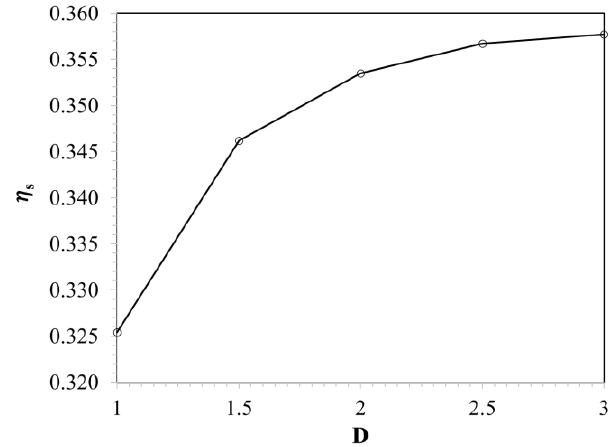
Figure 15. 𝜂 𝑠 with expansion behind the exit hole. Figure 15. η s with expansion behind the exit